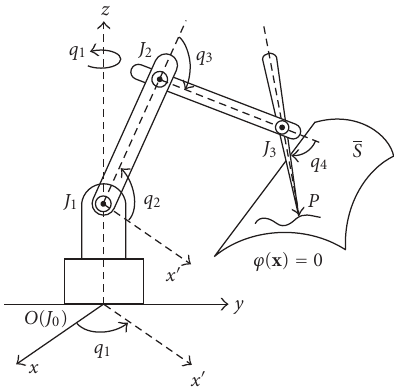
Figure 8: A handwriting robot with four DOFs whose endpoint P ( = ( x , y , z )) is constrained on a hypersurface ϕ ( x ) = 0, where ϕ ( x ) is a scalar function of C ∞